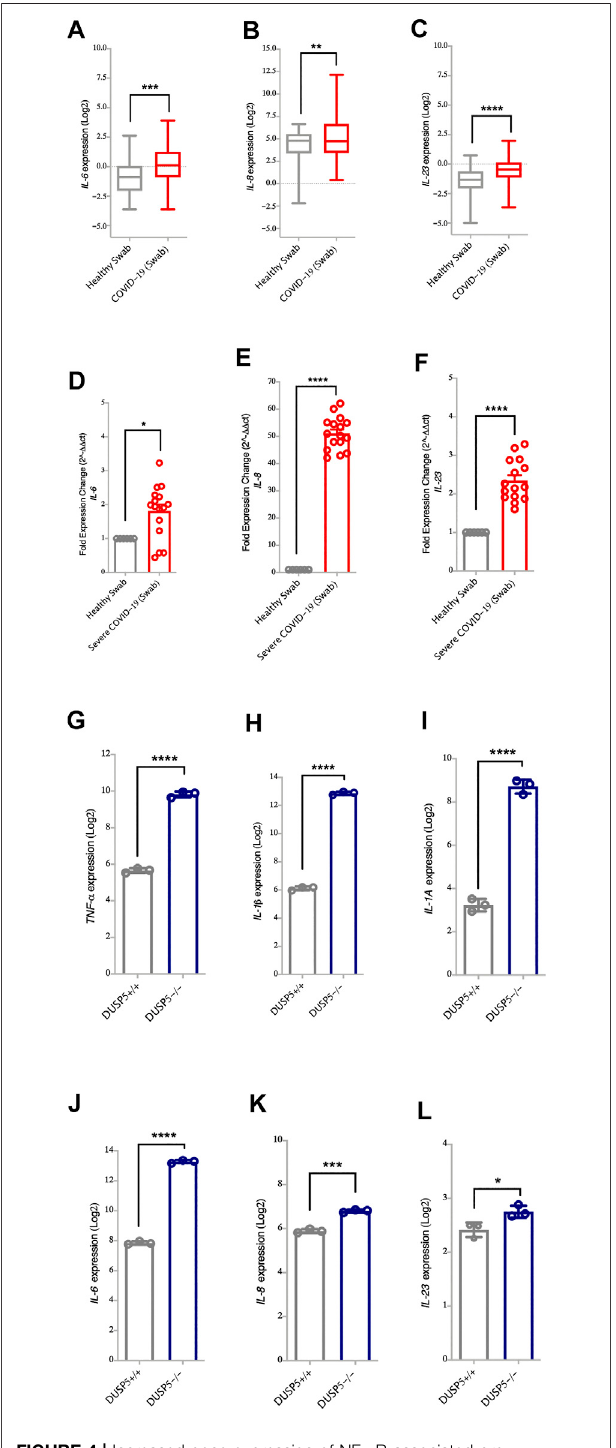
FIGURE 4 | Increased gene expression of NF- κ B associated pro- in fl ammatorycytokinesinnasopharyngealswabsofCOVID-19patients (A – C) Gene expression level of IL-6, IL-8 and IL-23 in nasopharyngeal swabs from COVID-19 patients ( n (cid:1) 430) and healthy controls ( n (cid:1) 54) (Dataset GSE152075). Expression level of IL-6, IL-8 and IL-23 is higher in nasopharyngeal swabs from COVID-19 patients as compared to healthy